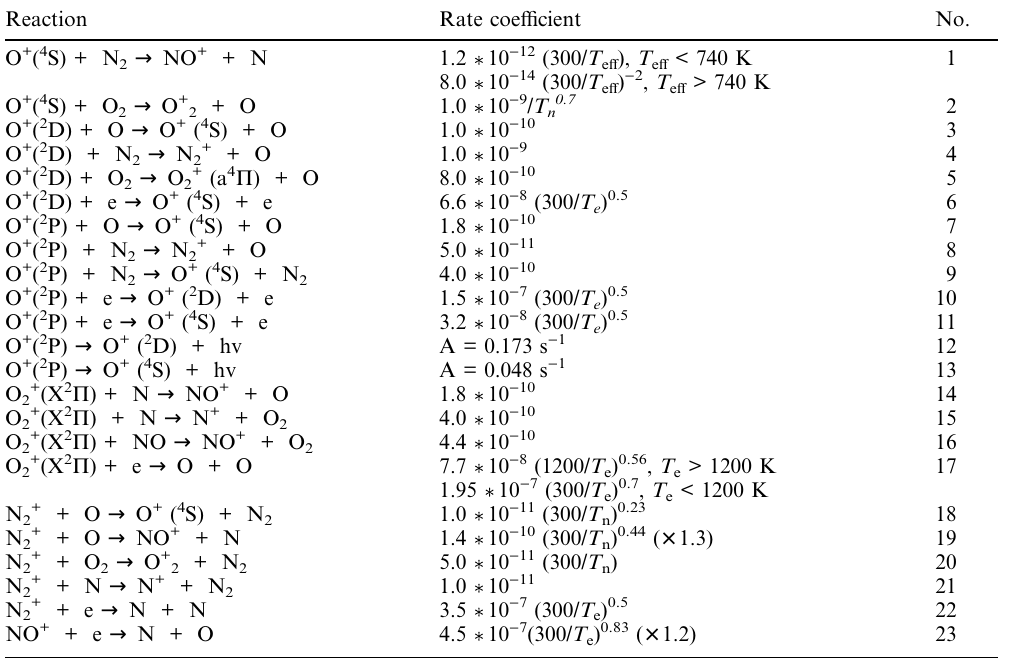
Table 1. chemical reactions included in the self-consistent model. T eff = ( m i T n + m n T i ) / ( m i + m n ) + 0.329 E 2 , where E is the electric field perpendicular to the geomagnetic field in